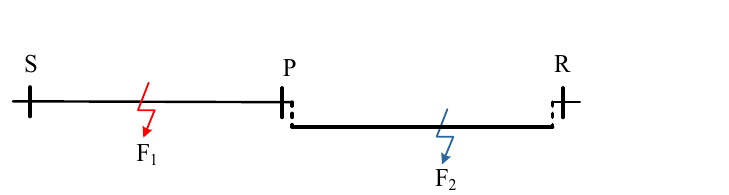
Figure 8. Schematic diagram of type A cable hybrid transmission